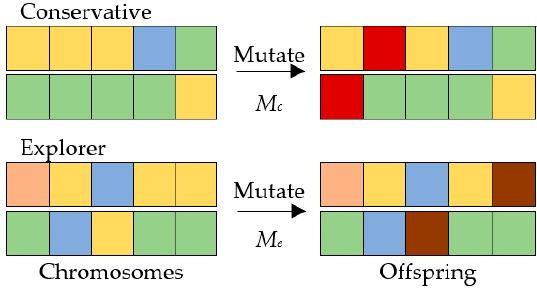
Figure 7. Mutation operation in an MSGA.